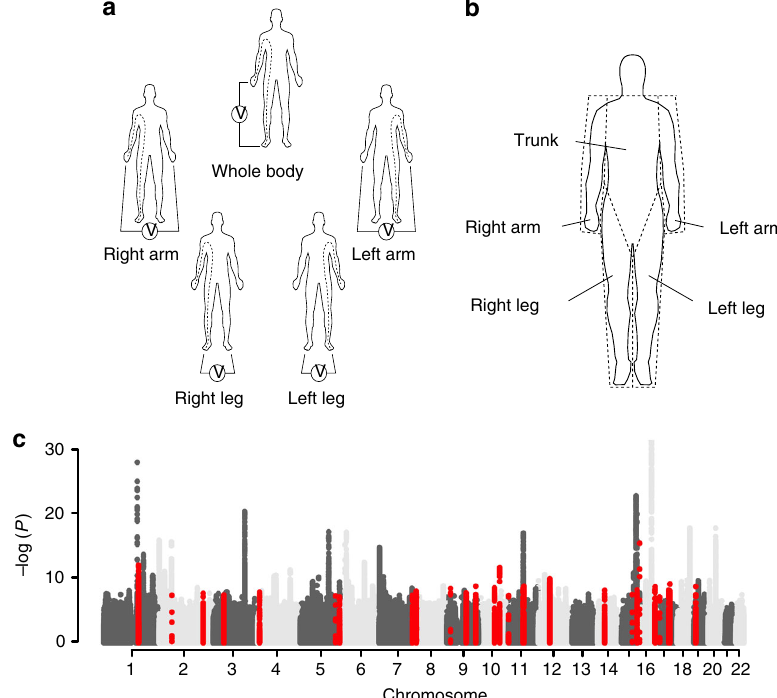
Fig. 1 Segmental body impedance analyses. This method uses bio-electrical impedance to estimate body composition: fat mass, muscle mass, etc. In this study, adipose tissue mass was estimated using the Tanita BC-418MA body composition analyzer ( a ). This machine uses an eight-electrode method, which allows for fi ve measurements of impedance. Electrical current is supplied to the front of both feet and the fi ngertips of both hands. Voltage is measured on either heel or thenar portion of the palms. Body composition is derived from a regression formula for each body part. The formula is derived from regression analysis using height, weight, age and impedance for each body part as predictors for composition of each body part as assessed by DXA ( b ). GWAS for AFR, LFR, and TFR were conducted in the UK Biobank cohort and revealed associations with loci that have not previously been associated with standard anthropometric traits. c A manhattan plot with combined results for association studies of body fat ratios in combined and sex-strati fi ed analyses. Overall, 135 independent associations with at least one of the body fat ratios were observed in the discovery analyses. Out of the initial 135 associations, 98 replicated; of which 30 replicated for AFR, 44 for LFR and 66 for TFR. Loci that have not previously been associated with an anthropomorphic trait are highlighted in red ( N =